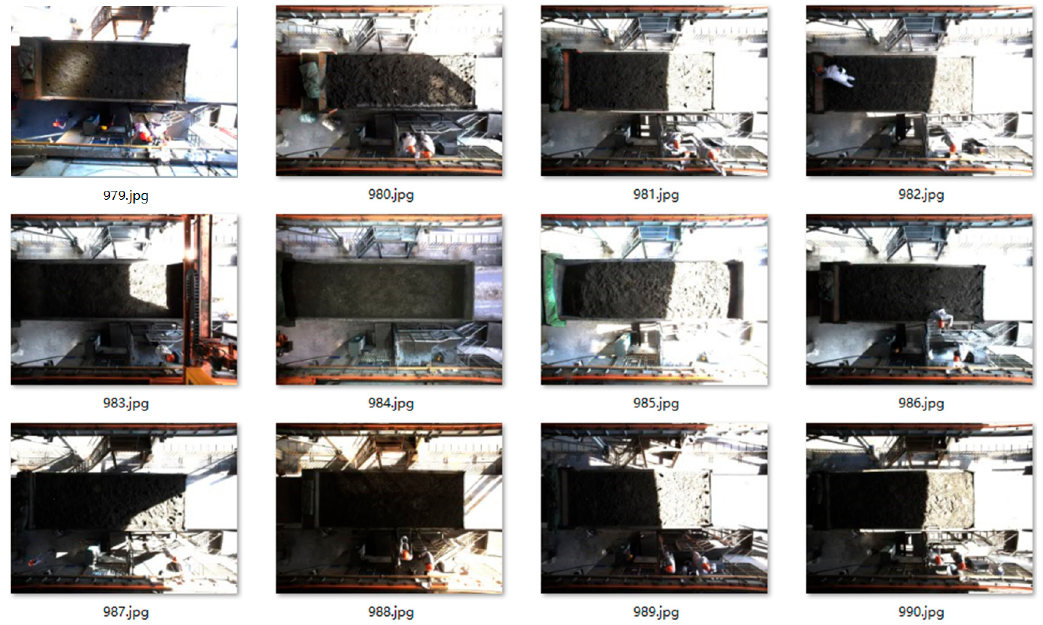
Figure 10. Some training set pictures.